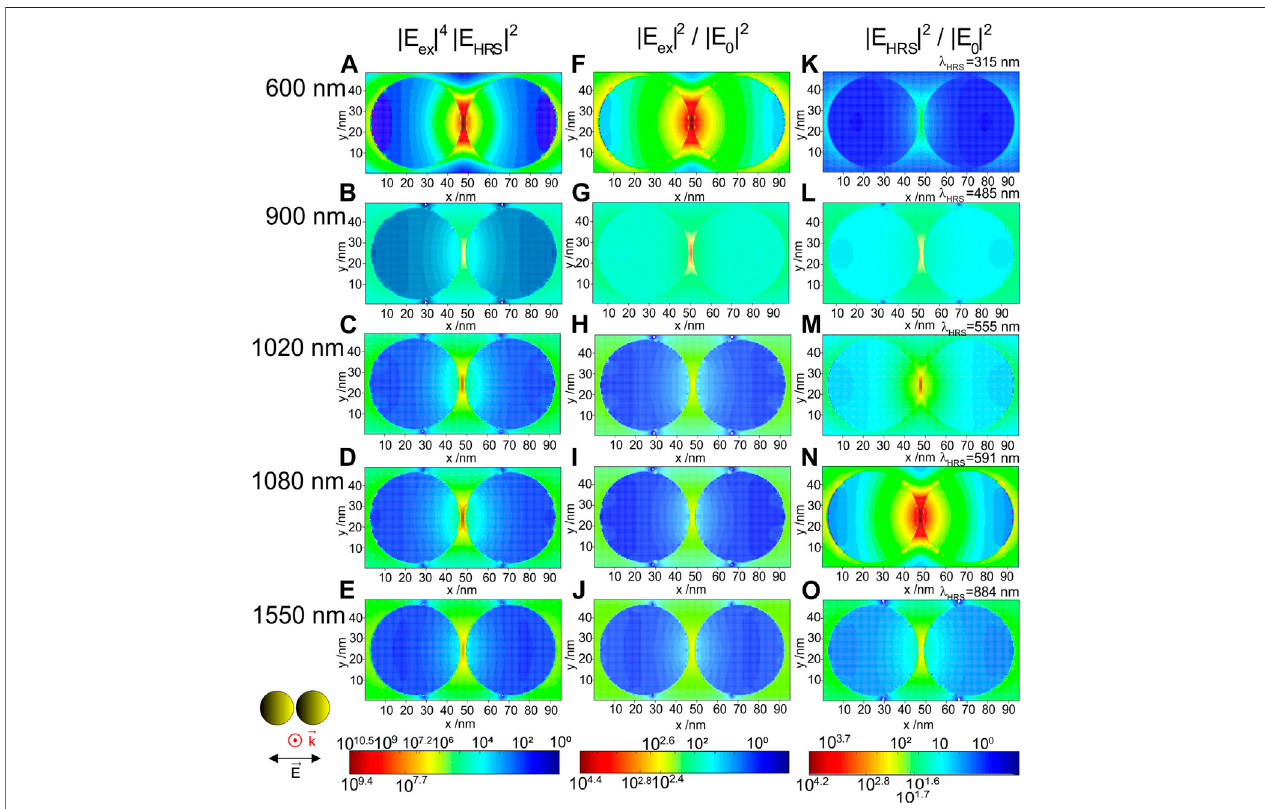
FIGURE 3 | (A – E) SEHRS enhancement of a gold nanosphere dimer and corresponding normalized fi eld intensities at (F – J) excitation wavelengths, and at (K – O) StokesHRS wavelengthsin the x,y-plane as result of3D FDTD simulations. The diameter ofthe gold nanospheresis 44 nm. Thegap betweenthe particles is2 nm. The propagation and polarizationoftheincidentplane waveare indicated. Themonitor isplaced inthe equatorialplane. The wavelength oftheHRSforeach ofthe excitation wavelengths corresponds to a molecular vibration with a wavenumber of 1,586 cm − 1 and is indicated in each of the panels (K) to (O) . The maximum SEHRS enhancement of 10 10.5 is found for an excitation wavelength of 600 nm (A) The highest excitation intensity enhancement, also observed at 600 nm has a value of 10 4.4 (F) . The maximum HRS intensity enhancement of 10 4.2 is obtained for a Stokes HRS wavelength of 591 nm, upon excitation at 1,080 nm (N) .